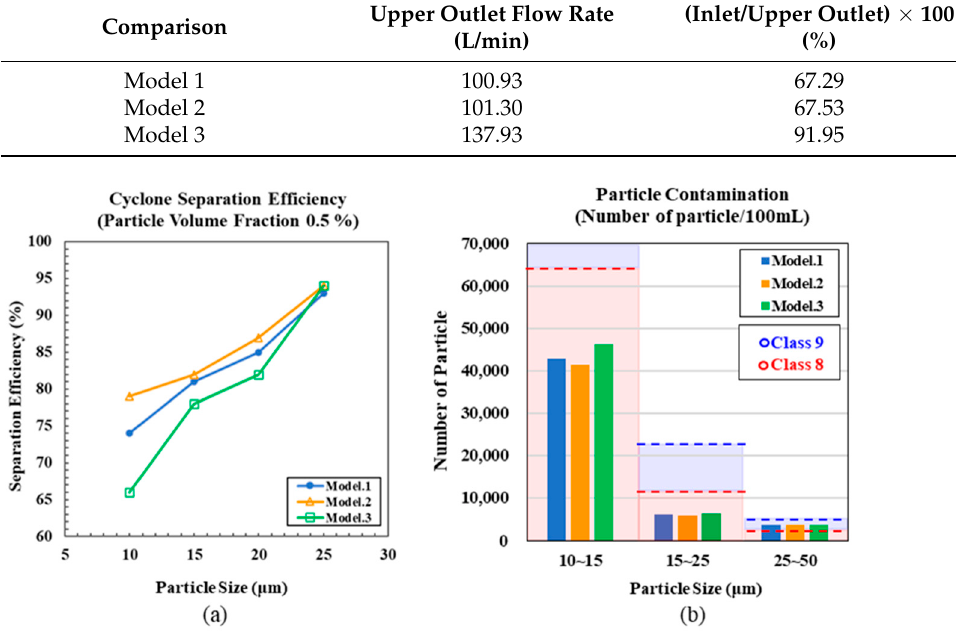
Figure 11. Comparison of cyclone filter performance; ( a ) Separation efficiency and ( b ) Number of particles contained in discharge fluid (100 mL).